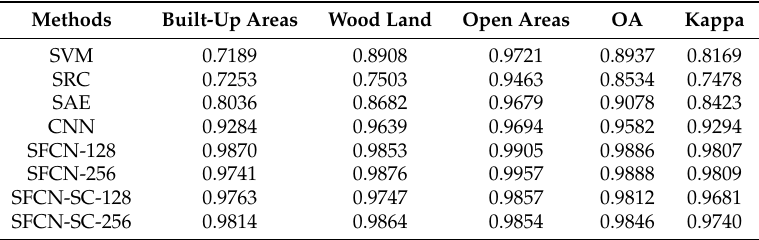
Figure 6. Classification results of Oberpfaffenhofen with different methods. ( a ) PauliRGB image; ( b ) ground truth map; ( c ) SVM; ( d ) SRC; ( e ) SAE; ( f ) CNN; ( g ) SFCN-128; ( h ) SFCN-256; ( i ) SFCN-SC-128; ( j ) SFCN-SC-256. Table 3. Classification results of Oberpfaffenhofen with different methods.